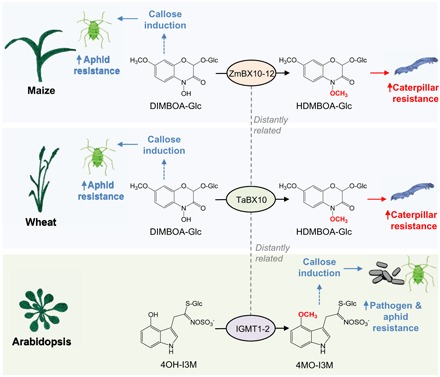
Independently evolved O-methylation of benzoxazinoids and glucosinolates regulates defense and resistance.DIMBOA-Glc is required for callose induction in wheat and maize. Methylation of DIMBOA-Glc to HDMBOA-Glc reduces the DIMBOA-Glc pool and subsequently suppresses callose formation. The responsible OMTs, TaBX10 and ZmBX10–ZmBX12, evolved independently from each other. HDMBOA-Glc repels caterpillars, while DIMBOA-Glc reduces aphid growth, most likely by promoting callose formation. In Arabidopsis, methylation of the glucosinolate 4OH-I3M by IGMT1 and IGMT2 leads to the formation of 4MO-I3M, which is required for callose deposition in this species. 4MO-I3M increases aphid and pathogen resistance, most likely by promoting callose formation. IGMT1 and IGMT2 are only distantly related to cereal benzoxazinoid OMTs.